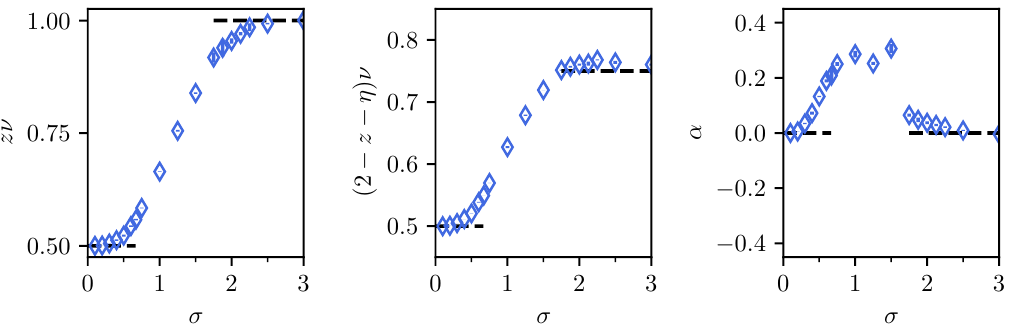
Figure 2: Exponents extracted by (biased) DlogPadé extrapolants of high-order se- ries from pCUT as a function of the decay parameter σ . The field-theoretical pre- dictions in the long-range mean-field regime with σ < 2 / 3 (see Tab. 3: z ν = 1 / 2, ( 2 − z − η ) ν = 1 / 2, α = 0) as well as the well-known short-range critical exponents [ 53 ] (see Tab. 3: z ν = 1 / 2, ( 2 − z − η ) ν = 3 / 4, in the short-range regime σ > 2 − η SR α = 0) are depicted by black dashed lines. The raw data used to extract the exponents and the numerical values of the exponents are provided in Ref. [ 71 ]